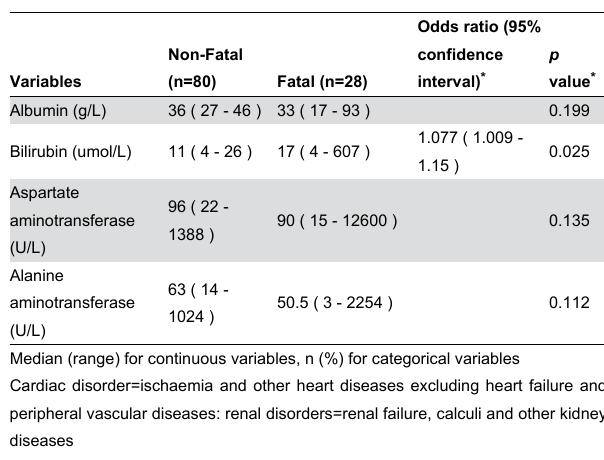
Median (range) for continuous variables, n (%) for categorical variables Cardiac disorder=ischaemia and other heart diseases excluding heart failure and peripheral vascular diseases: renal disorders=renal failure, calculi and other kidney diseases